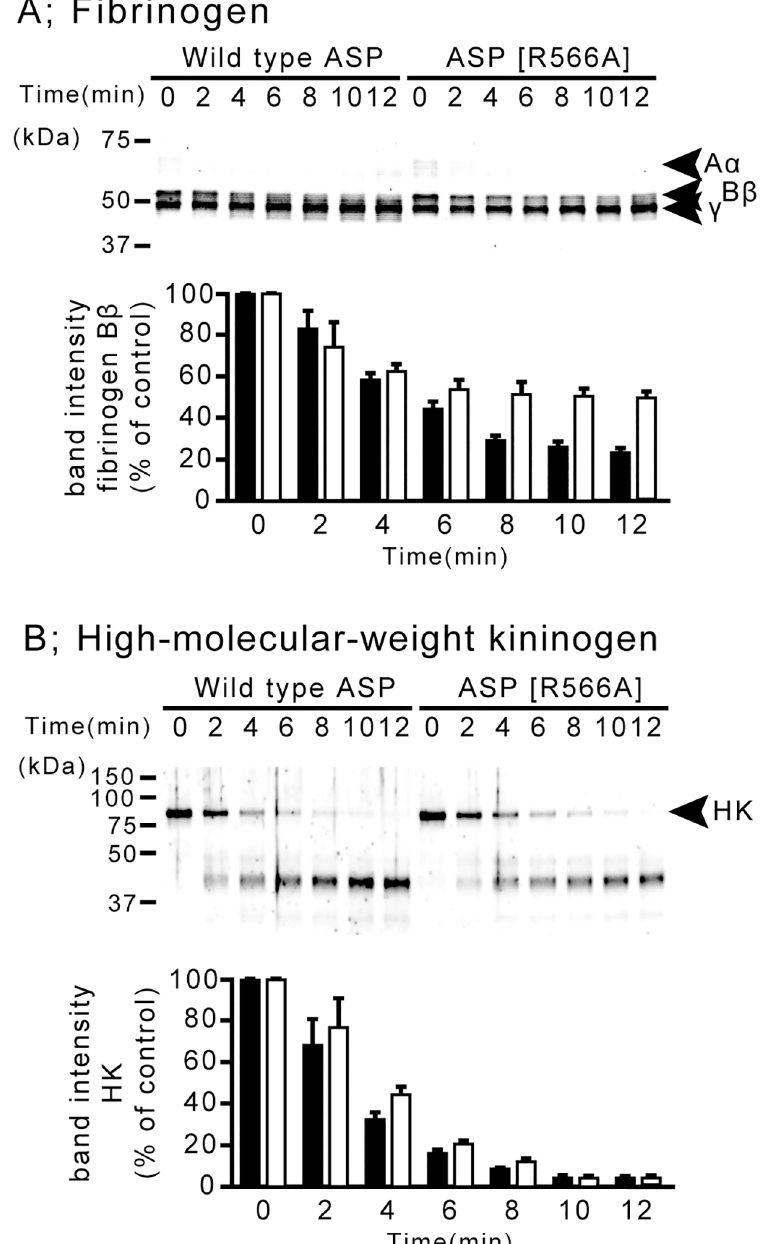
Fig 3. The cleavage of various proteins by ASP and ASP [R566A]. (A) Cleavageof fibrinogenby ASP and by ASP [R566A]. Human fibrinogen(200 nM) was incubatedwith ASP or ASP [R566A] (0.4 nM) for various periods of time (min). The locationsof fibrinogenA α , B β and γ chains are indicatedby the arrows (upper panel). The band intensity of fibrinogenB β incubatedwith ASP (black bar) or ASP[R566A] (white bar) was also shown in lower panel. (B) Cleavageof high-molecular-weightkininogen by ASP or ASP [R566A]. High- molecular-weightkininogen(200 nM) was incubatedwith ASP or ASP [R566A] (0.4 nM) for variousperiods of time (min). The locationof high-molecular-weightkininogen (HK) is indicatedby the arrow (upper panel). The band intensity of HK incubatedwith ASP (black bar) or ASP[R566A] (white bar) was also shown in lower panel. All experiments shown in this figure were performed